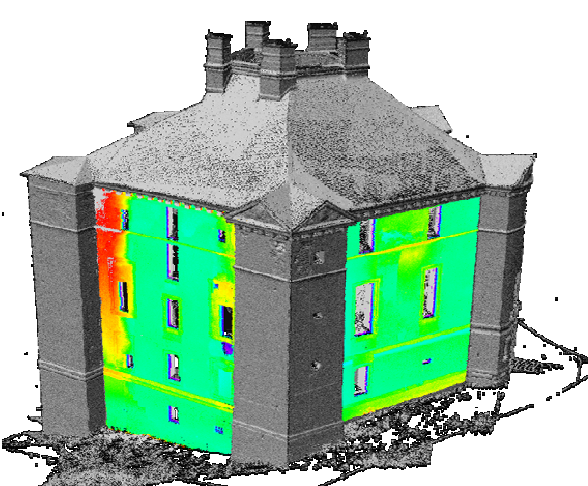
Figure 4. LIDAR in operation on the left bank of a dam